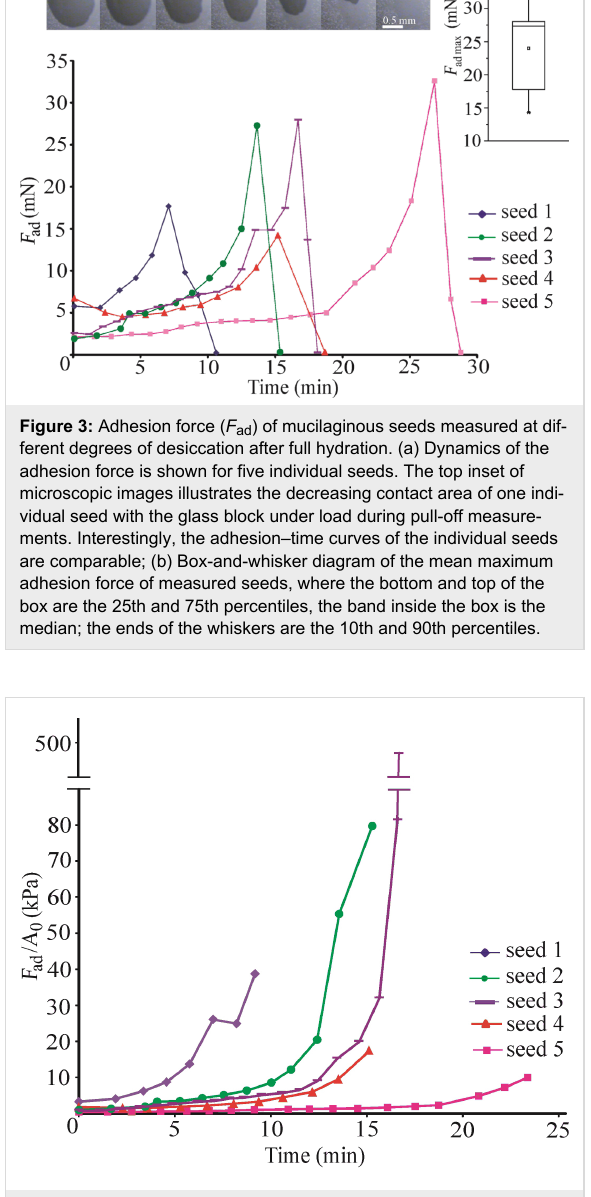
30 min of desiccation time, reached values of around 0.5–0.8